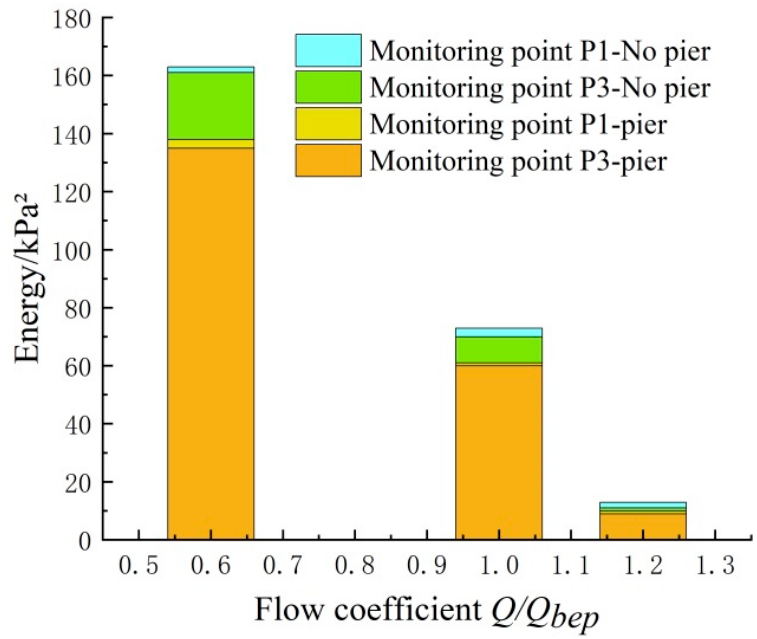
Figure 19. Energy comparison of two monitoring points with and without division pier.